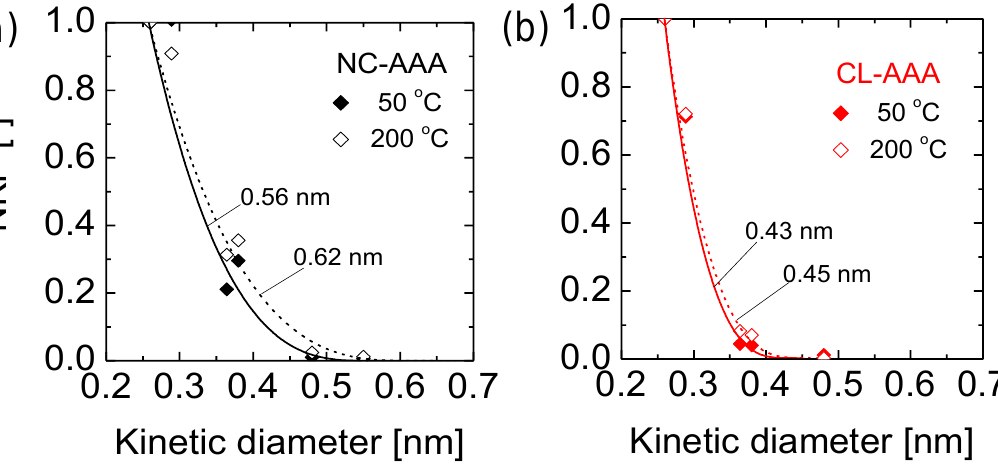
Figure 16. NKP as a function of kinetic diameter for estimating the mean pore size for ( a ) NC-AAA and ( b ) CL-AAA membranes. The solid and dashed lines are theoretical curves. Adapted from [93].